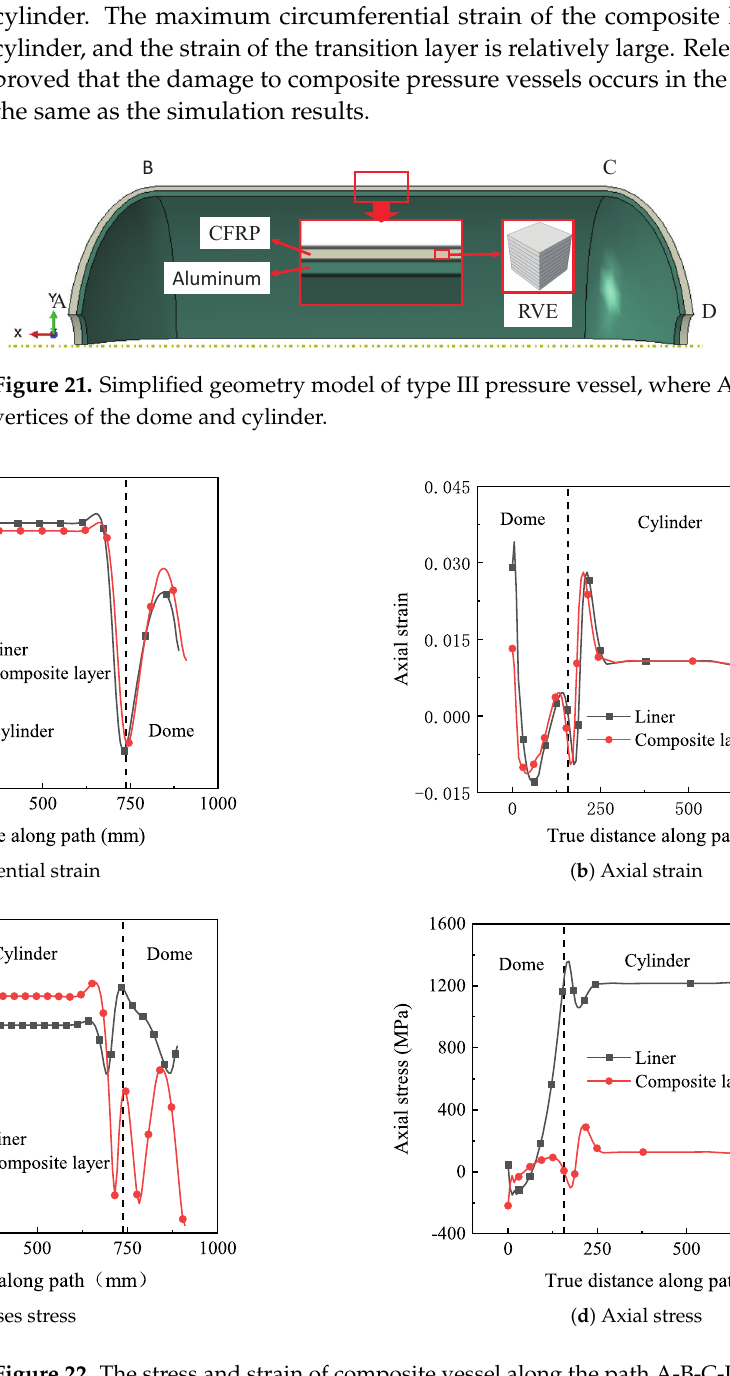
Figure 22. The stress and strain of composite vessel along the path